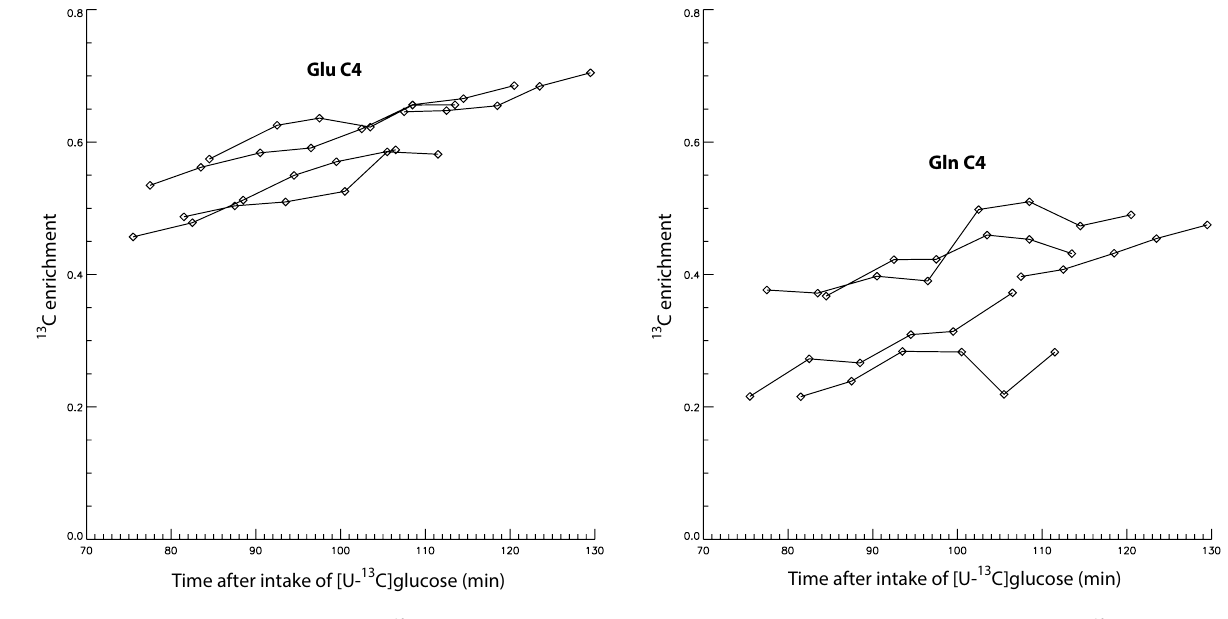
Figure 5. Plots of 13 C enrichments of Glu C4 and Gln C4 vs. time after oral administration of [U- 13 C]glucose for all five healthy participants.